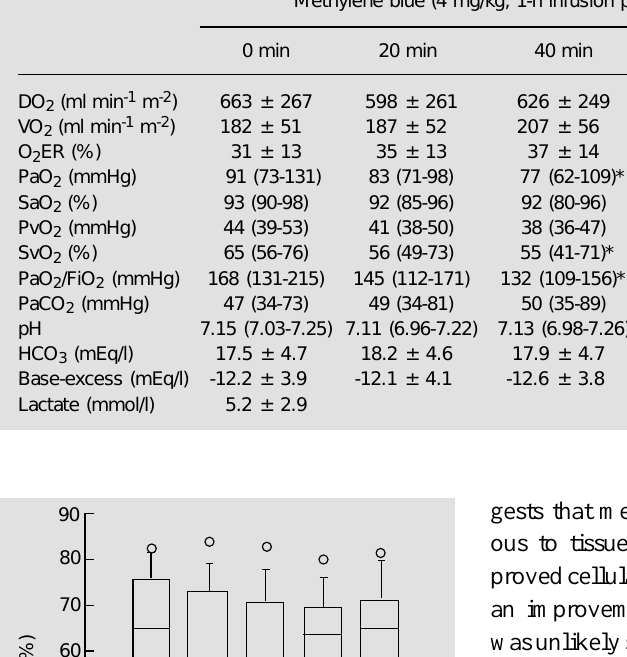
Table 3 - Metabolic variables. DO 2 , Oxygen delivery; VO 2 , oxygen consumption; O 2 ER, oxygen extraction ratio; PaO 2 , arterial oxygen tension; SaO 2 , arterial oxygen saturation; PvO 2 , mixed venous oxygen tension; SvO 2 , mixed venous oxygen saturation; PaO 2 /FiO 2 , arterial oxygen tension/inspired oxygen concentration ratio; PaCO 2 , arterial carbon dioxide tension; HCO 3 , bicarbonate. Data are reported as mean ± SD or median (25-75th percentiles) *P<0.05 compared with time 0 (Friedman repeated measures ANOVA on ranks). + P<0.05 compared with time 0 (one- way repeated measures ANOVA). Methylene blue (4 mg/kg; 1-h infusion period)